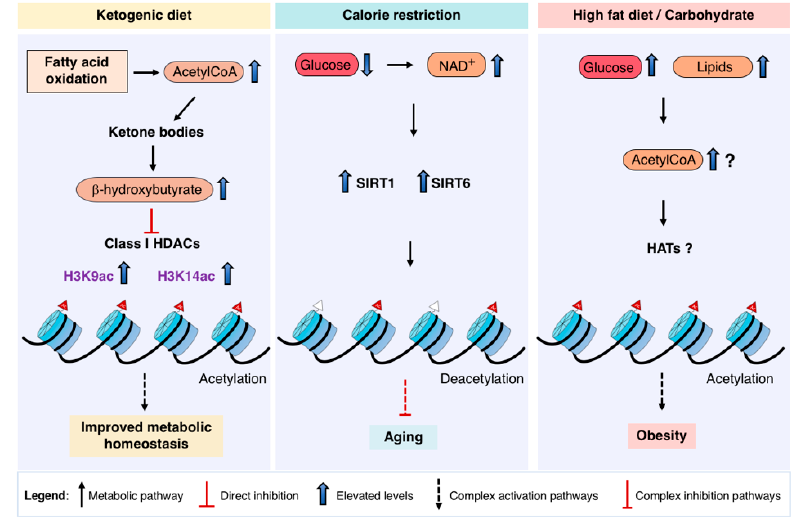
Figure 2. Influence of different diets in chromatin function. Ketogenic diet promotes increased fatty acid oxidation rates which elevates acetyl-CoA production and therefore ketone bodies. The ketone body β -hydroxybutyrate inhibits class I HDACs leading to increased H3K9ac and H3K14ac. Calorie restriction leads to increased NAD+ levels and activation of SIRT1 and SIRT6, which promote histone deacetylation and delays aging. Nutrient overload leads to obesity, it is not fully understood how acetyl-CoA pools may affect specific gene programs in the context of obesity. HDACS: Histone Deacetylases; HATS: Histone Acetyltransferases.